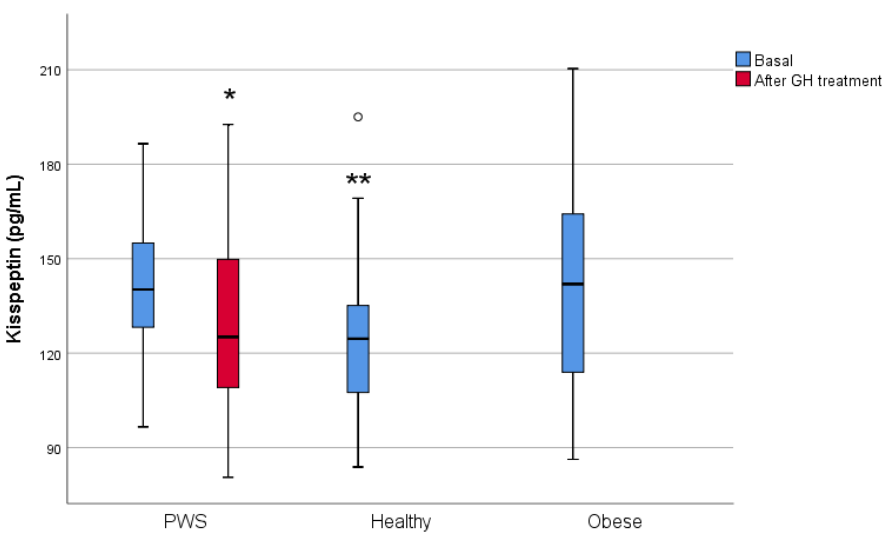
Figure 1. Kisspeptin levels at baseline in the three groups (blue) and after GH treatment in PWS (red). GH = growth hormone. * Willcoxon signed-rank test, p = 0.027 between baseline and post-GH treatment. ** Mann–Whitney U test with Bonferroni correction, p = 0.019 between PWS and healthy groups. Outliers are represented as circle